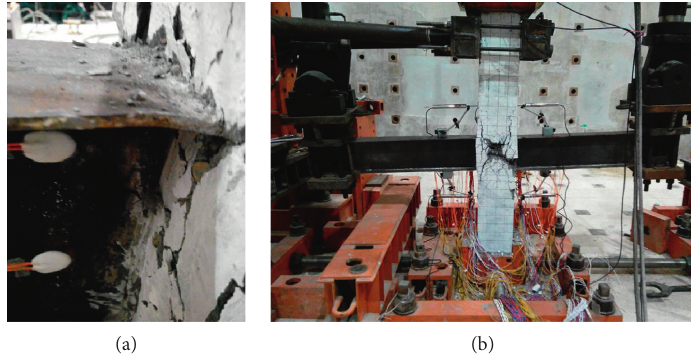
Figure 7: Failure modes of SRC-4. (a) Top flange buckling of beam. (b) Final failure